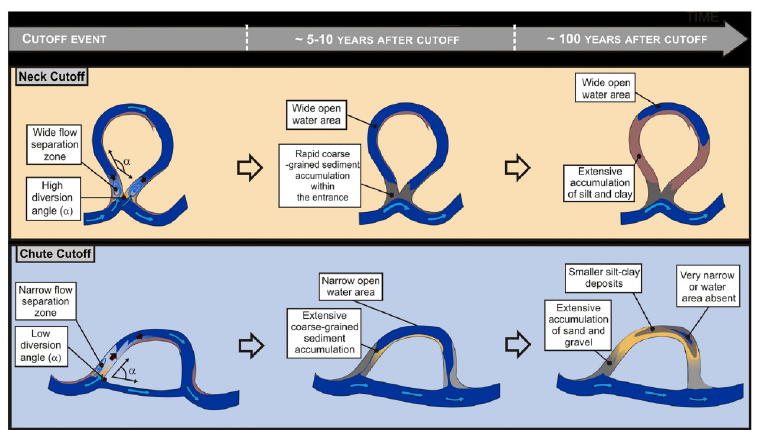
Fig 1. Schematic representation of the geomorphic evolution of meander cutoff